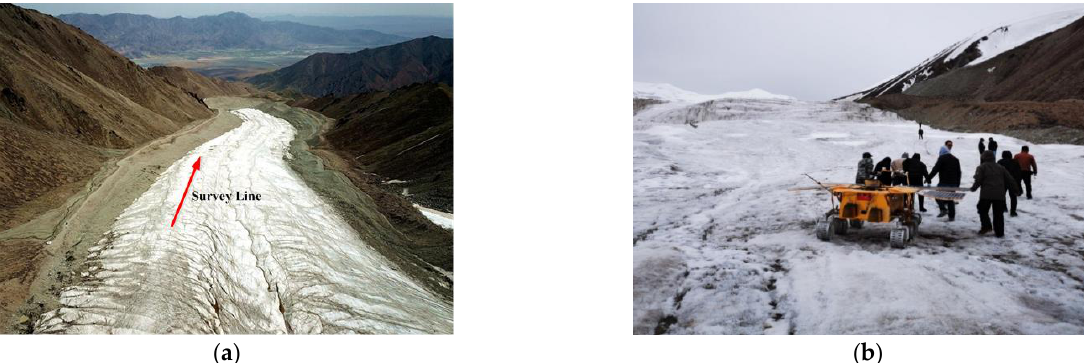
Figure 12. Path and site of verification. ( a ) The red arrow indicates the survey line of the Mars Rover-mounted Subsurface Penetrating Radar (RoSPR) on the glacier. ( b ) The RoSPR is detecting the thickness of the glacier.